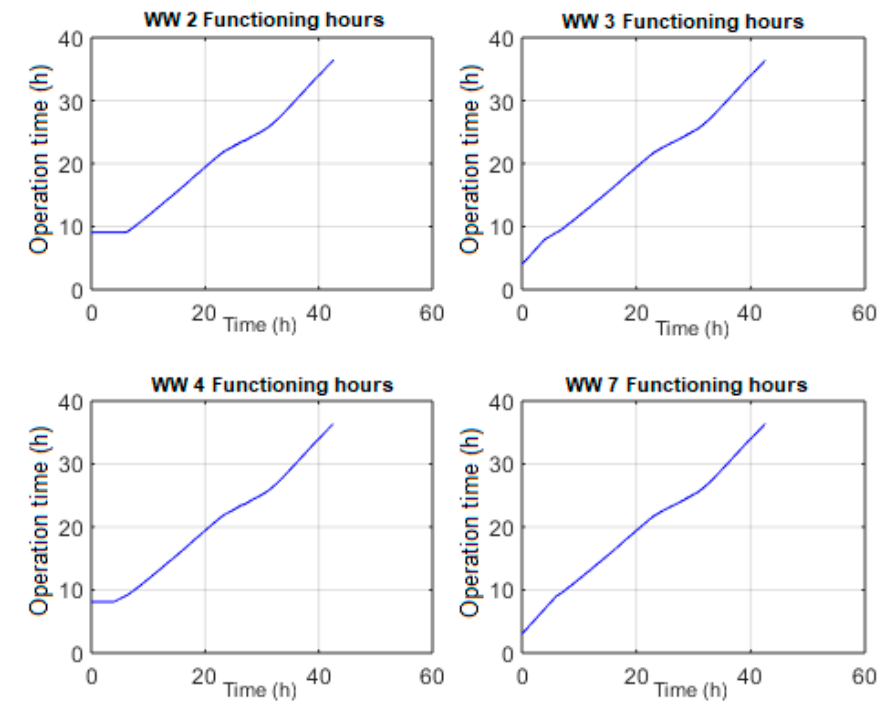
Figure 7. Water wells functioning hours in the test scenario.